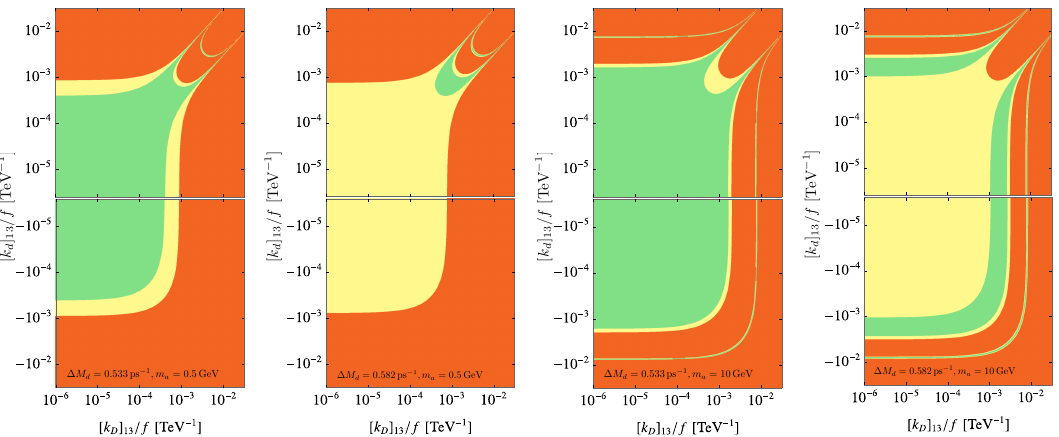
Figure 13 . ALP couplings for which the mass difference ∆ M d is reproduced within 1 σ (green) or 2 σ (yellow) for m = 0 . 5 GeV (two left panels) and m = 10 GeV (two right panels) using recent a a weighted averages (first and third panels) and FLAG 2019 values (second and fourth panels) for the SM prediction. The orange region is excluded at 2 σ